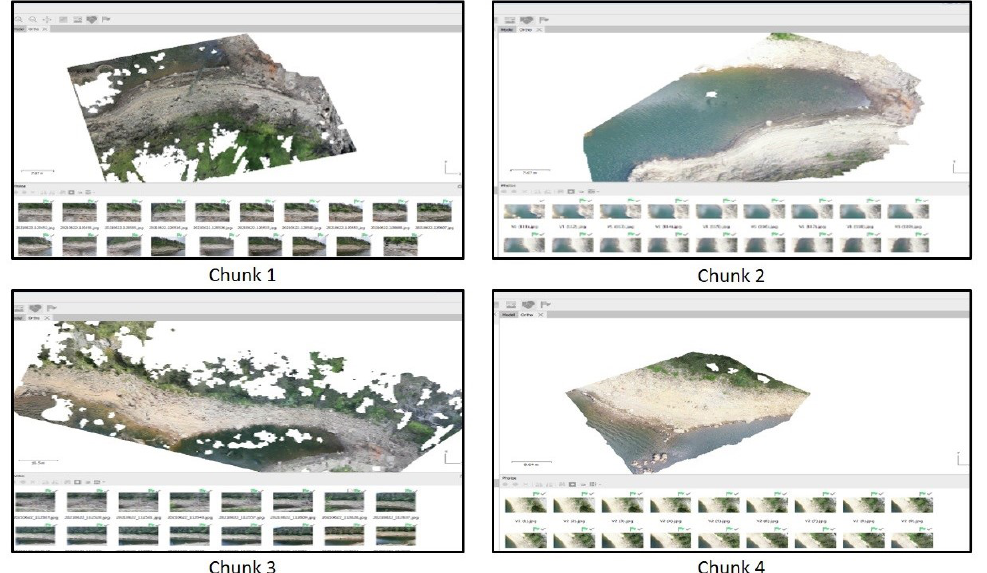
Figure 5. Area covered by each of the four datasets through the processing of data using Agisoft Metashape©